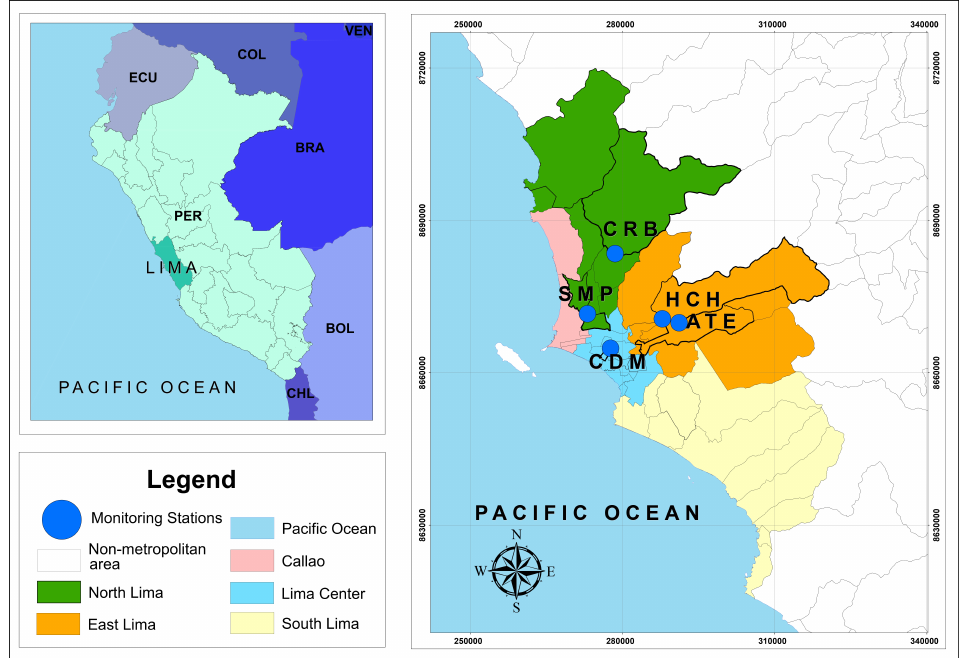
Figure 1. Geo-spatial locations of the five monitoring stations: Ate (ATE), Jesús María (CDM), Carabayllo (CRB), Huachipa (HCH) and San Martín de Porres